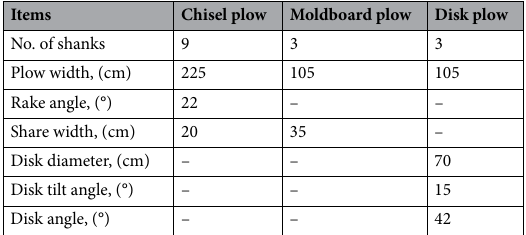
Table 1. The characteristics of the investigated